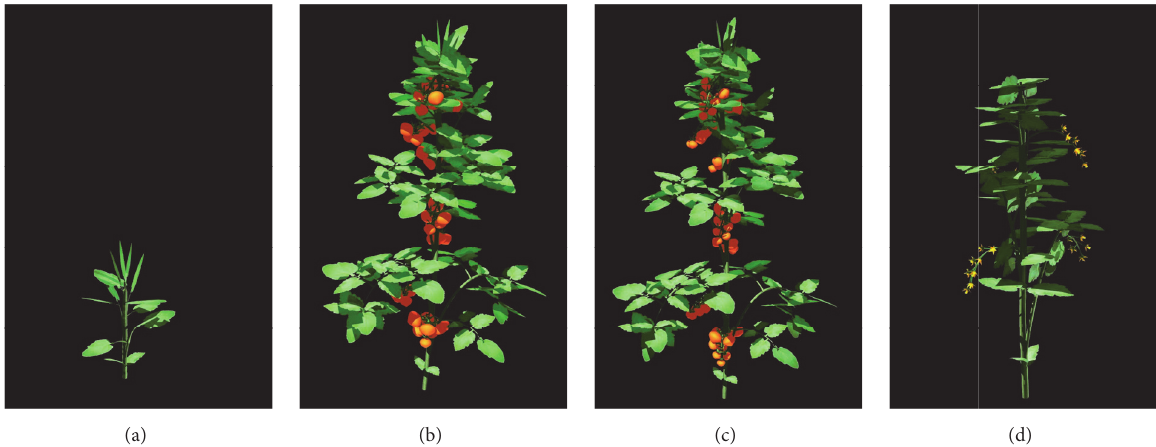
Figure 13: The simulated results (after planting 105 days) of tomato growing in different seasons according to CA daily average temperature. Planting on the 50th day (a), the 120th (b), the 190th (c), and the 260th day (d) of the year.